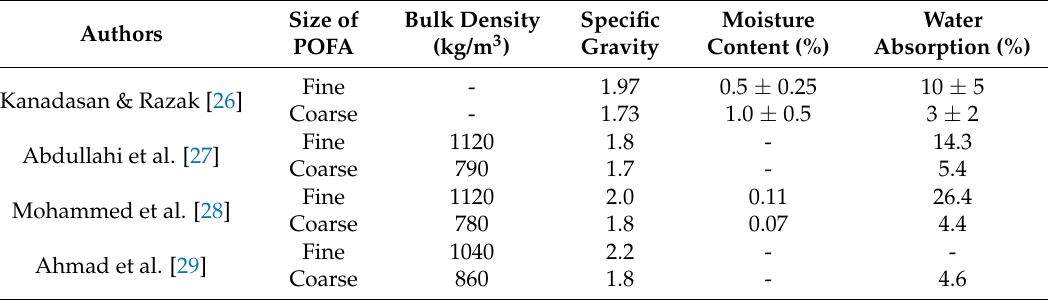
Table 3. Physical properties of palm oil fuel